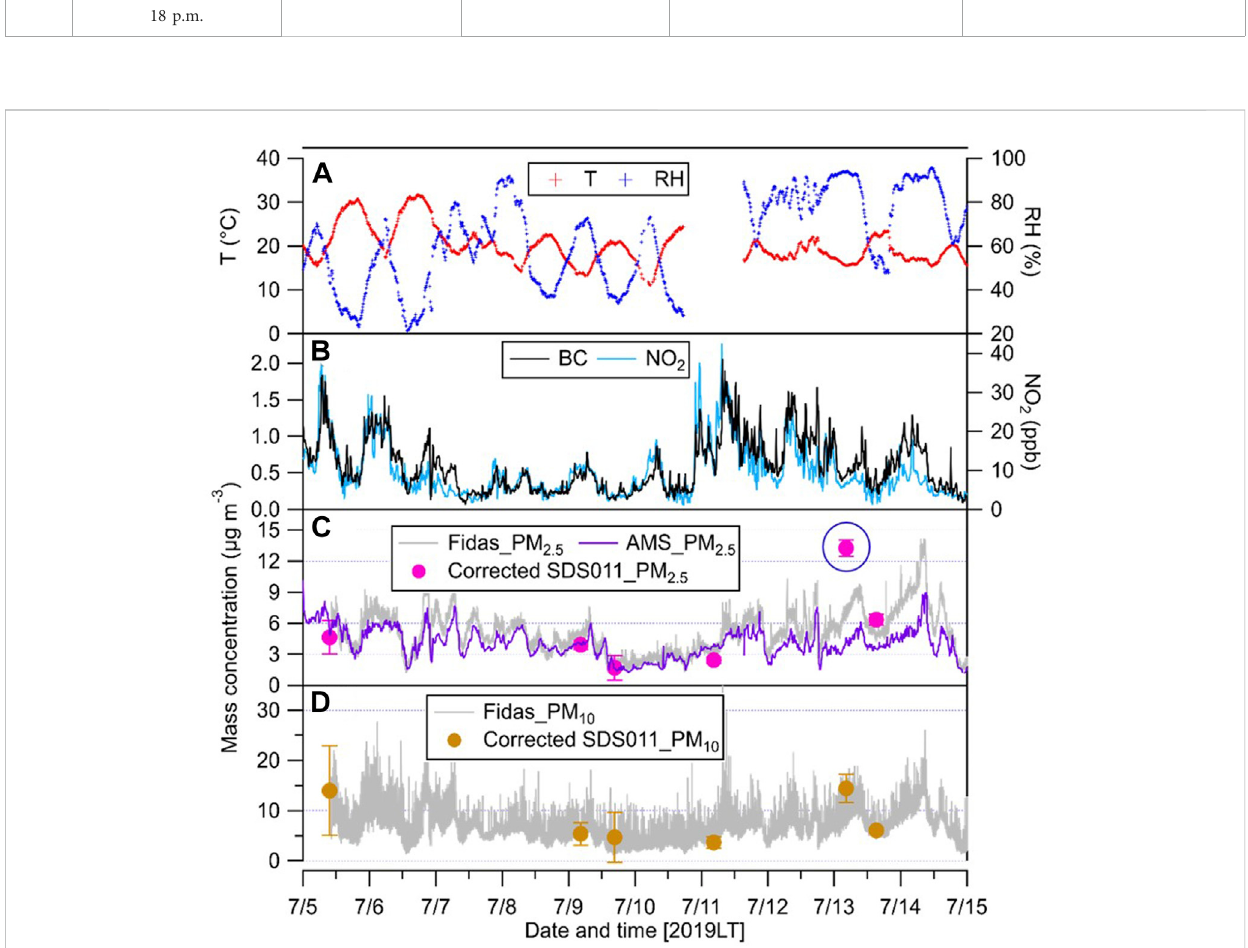
FIGURE 4 (A) Time seriesof air temperature (T)and relativehumidity(RH), (B) Blackcarbon(BC) and NO PM 2.5 measuredbyanaerosolmassspectrometer(AMS,Songetal.,2022)intheairqualitymonitoringcontaineratDurlacherTor.The5-minaveragedata ofSDS011atthestartingandendpointnearthecontainerareplottedforcomparison.Thebluecyclein (C) indicatesthemorningmeasurementtourdata on 13 July 2019 with high RH conditions ( >